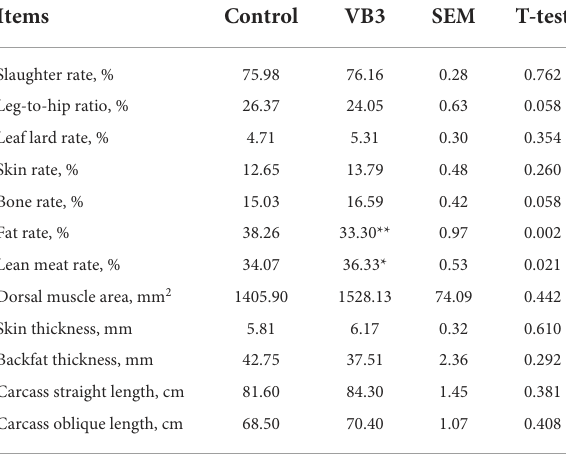
TABLE 4 Effects of dietary supplementation of niacin on meat quality of Ningxiang pigs a .